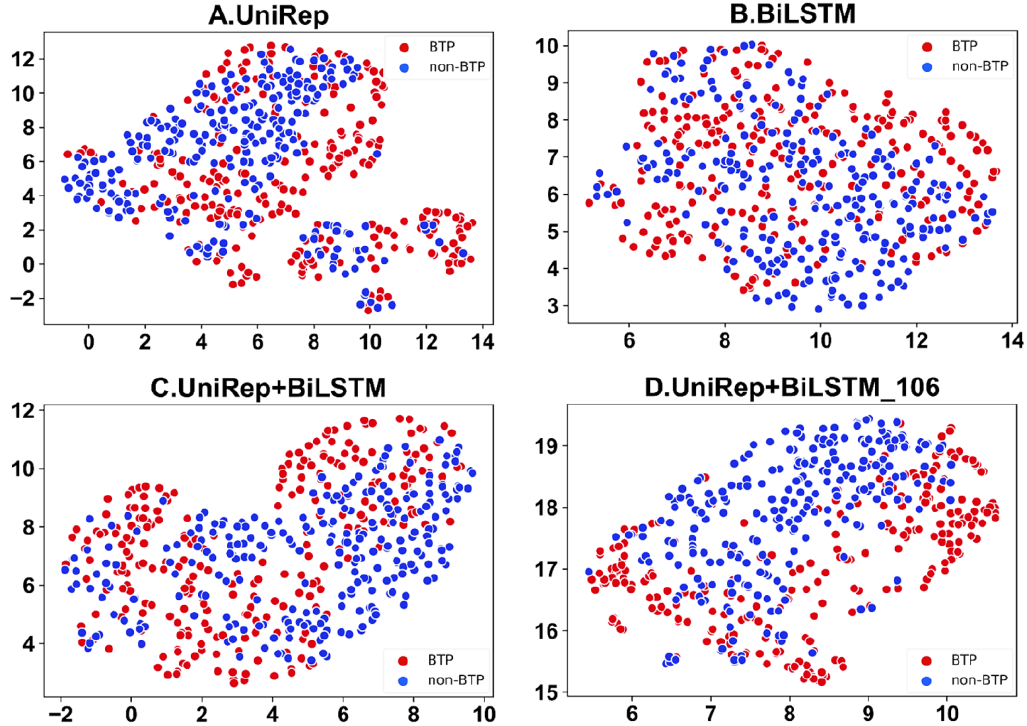
Figure 5. UMAP was used to visualize the dimension-reduced features of fused features: ( A ) is the UniRep feature, ( B ) is the BiLSTM feature, ( C ) is the BiLSTM + UniRep fusion, and ( D ) represents data using the first 106 features selected from the BiLSTM_UniRep fusion feature set.